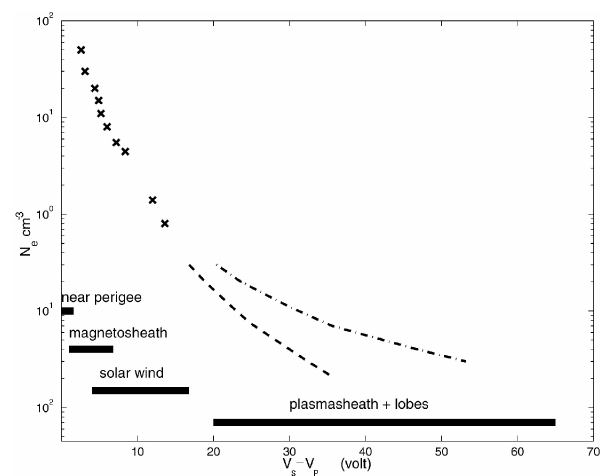
Figure 2. Fig. 2. Calibration of the spacecraft to-probe-potential difference ( V S − V P ) in solar wind with electron densities measured by Whis- per(crosses). Dotted lines indicate the expected range of ( V S − V P ) in the plasmasheath and lobes, to be calibrated later with particle